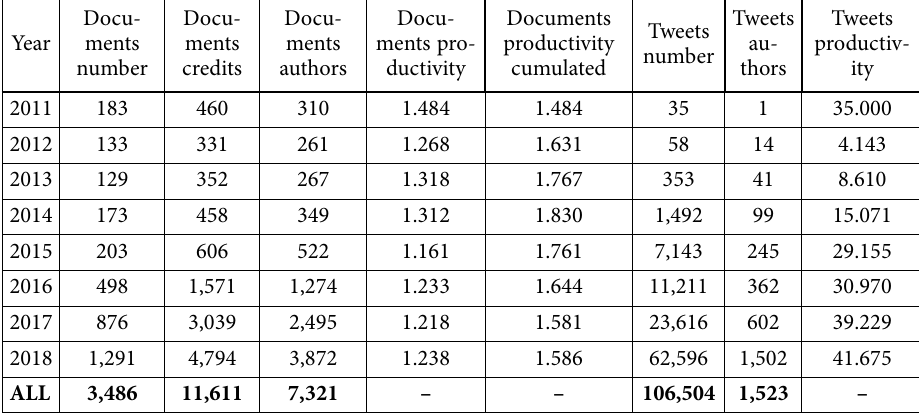
Table 4. Productivity in the field of the circular economy (source: own study based on Web of Science, Scopus, and